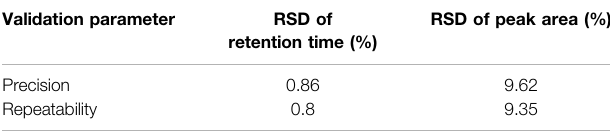
TABLE 1 | Stimulation method of CUMS model. Validation